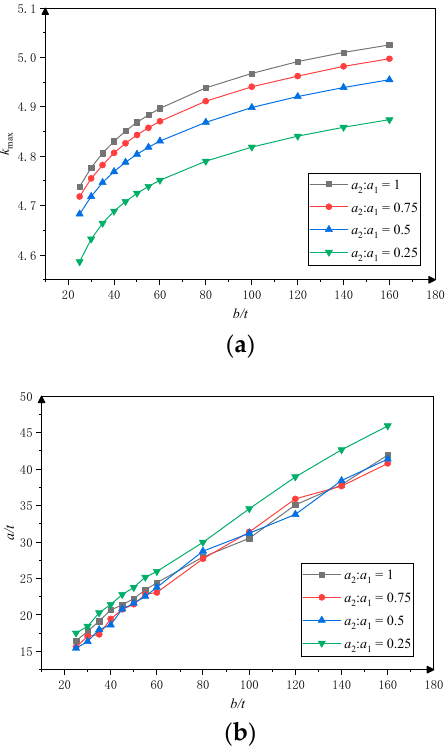
Figure 12. Parameters for k = k max : ( a ) b/t - k max ; ( b ) b/t - a/t